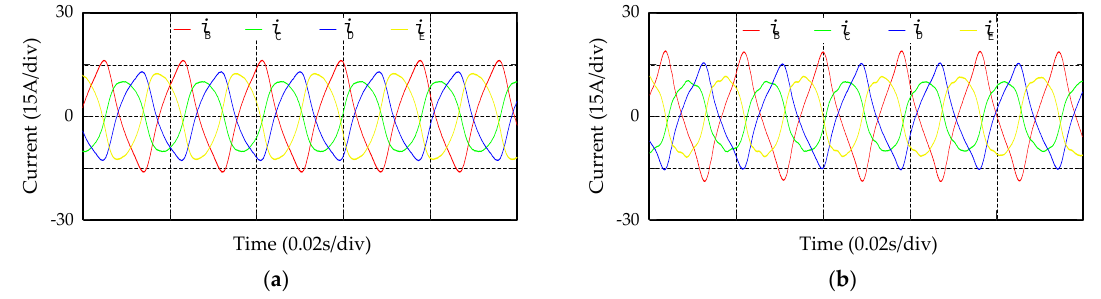
Figure 15. Current waveform of five-phase PMSM: ( a ) Current waveform of removing faulty phase after a short-circuit; ( b ) Current waveform after adding RC.